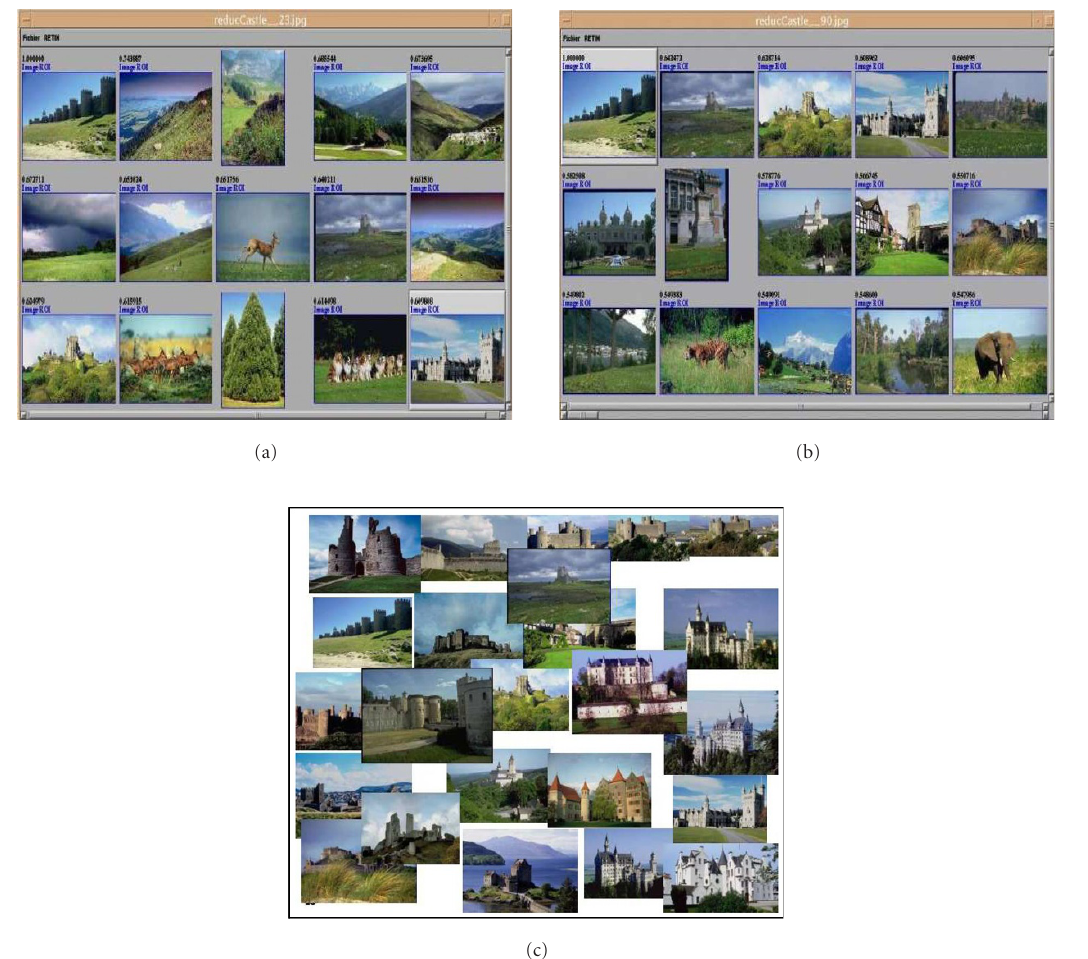
Figure 11: Retrieval strategy comparison: (a) the top-15 result without feedback, (b) result using the simple feedback retrieval strategy , and (c) the exploration strategy